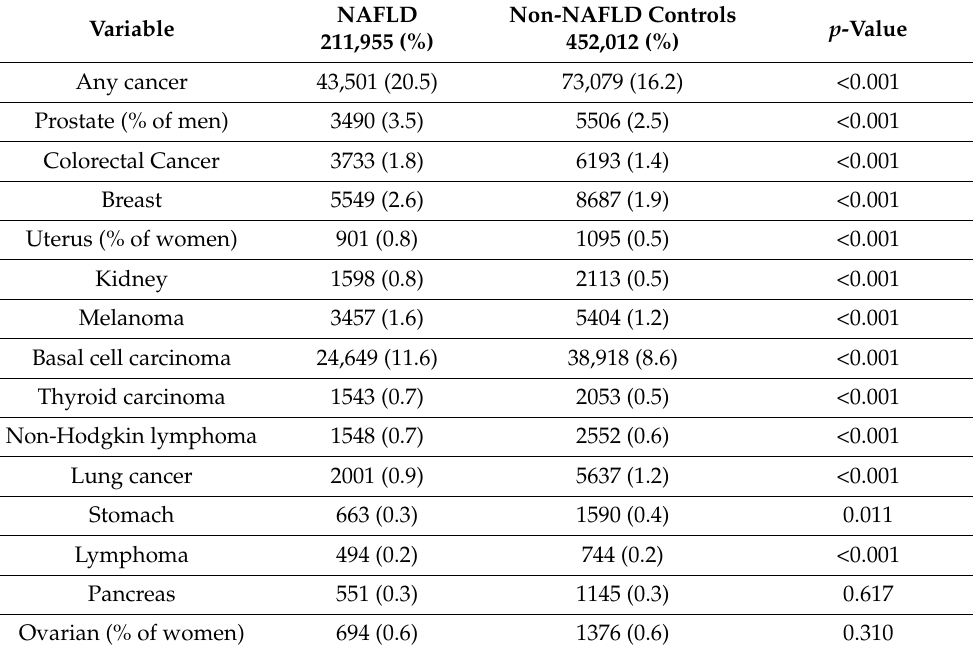
Table 2. Malignancy rates among NAFLD and Non-NAFLD